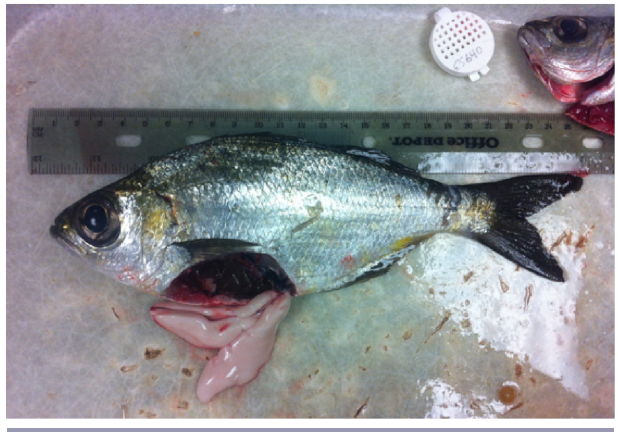
Fig. 3 . Endemic Hawaiian flagtail ( Aholehole, Kuhlia xenura ) with enlarged male gonad caught from Maunalua Bay March 2014 (fork length = 21